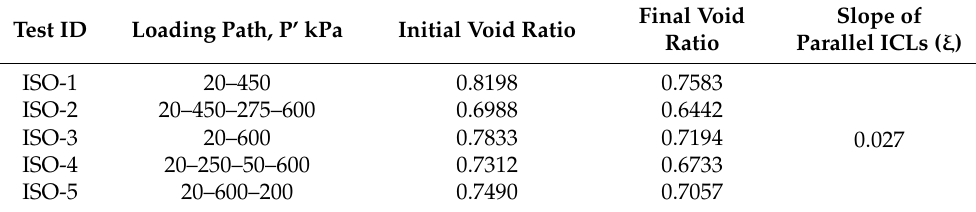
Figure 3. Trimming of the intact samples .